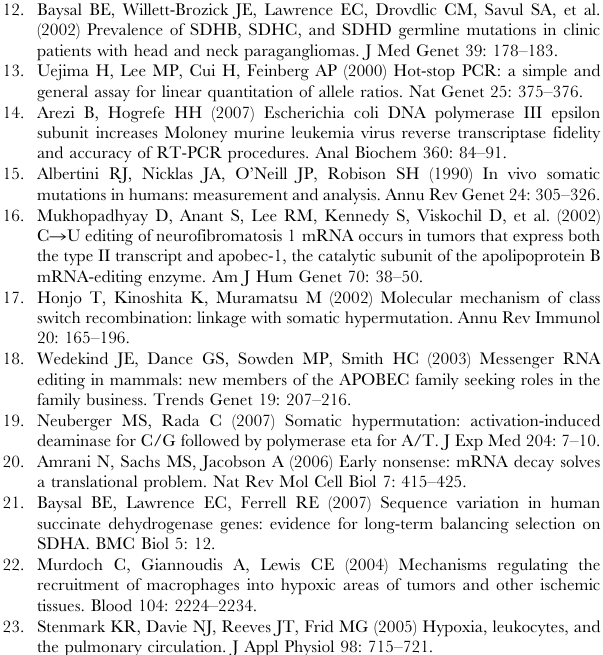
Figure S4 The Ala15Thr mutation in Jurkat cell line. Multiple sequence alignment (Clustal W 1.83) of N-terminal sequences of SDHB gene products demonstrates that human Ala15 is conserved (shown by red fonts) in most organisms which are denoted by their genus names. All sequences detected by the default parameters of BLAST analyses (http://www.ncbi.nlm.nih.gov/BLAST) are shown. Table S1 Oligonucleotide PCR primers used to amplify SDH subunit genes by nested PCR. * Primers used in both rounds of the nested PCR.